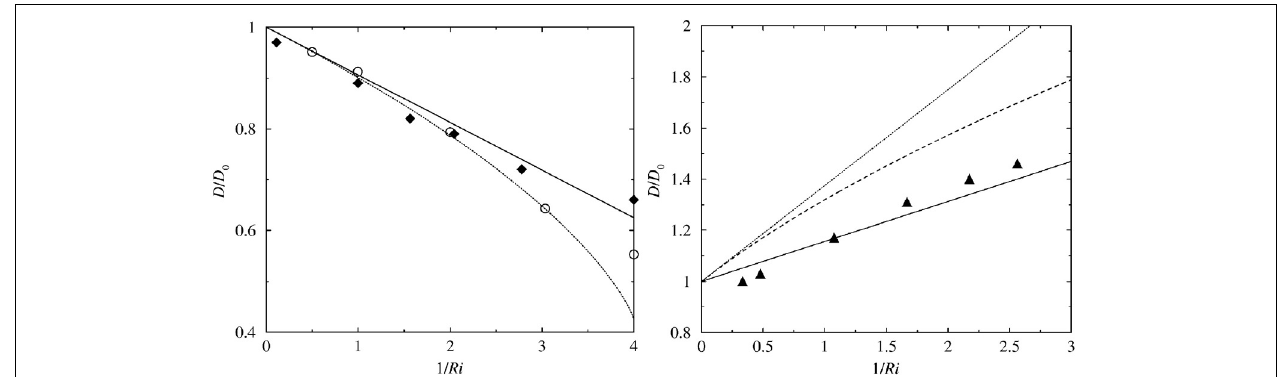
FIGURE 3 | Normalized drag as a function of Ri . Left: drag for wind profile (38) as given by (42) (solid line), from (40) (dotted line), and from numerical simulations (symbols). Right: drag for wind profile (41) as given by (43) (solid line), from Grisogono [60] (dashed